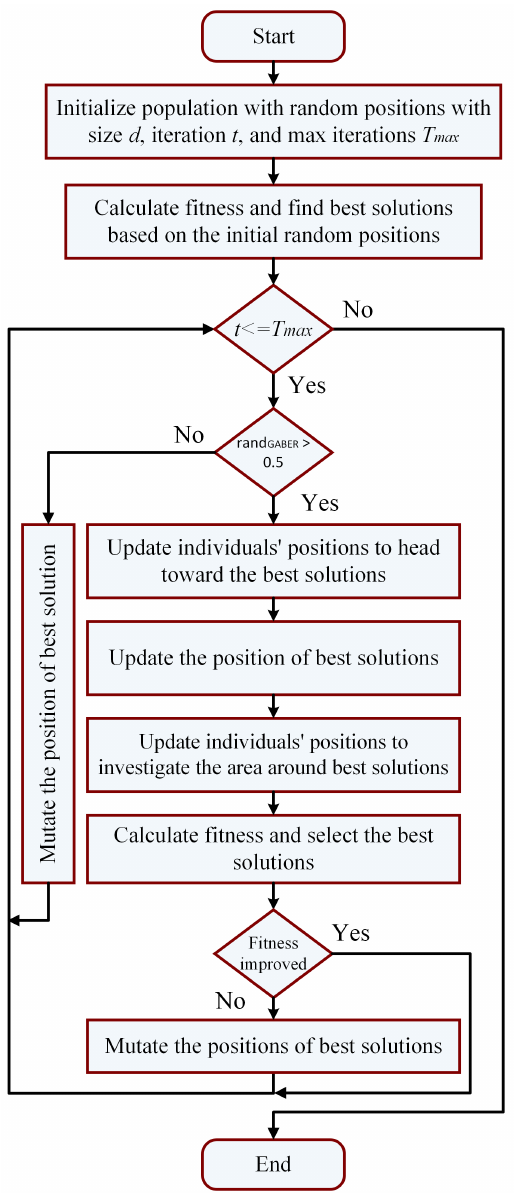
Figure 7. Flowchart of the steps of the proposed GABER optimization